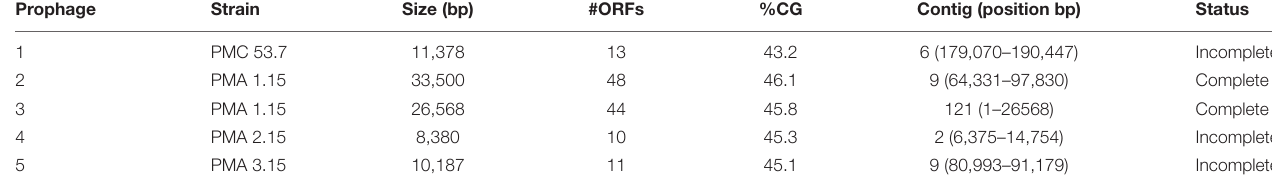
TABLE 5 | Unique prophage-related sequences distributed in V. parahaemolyticus strains. Prophage